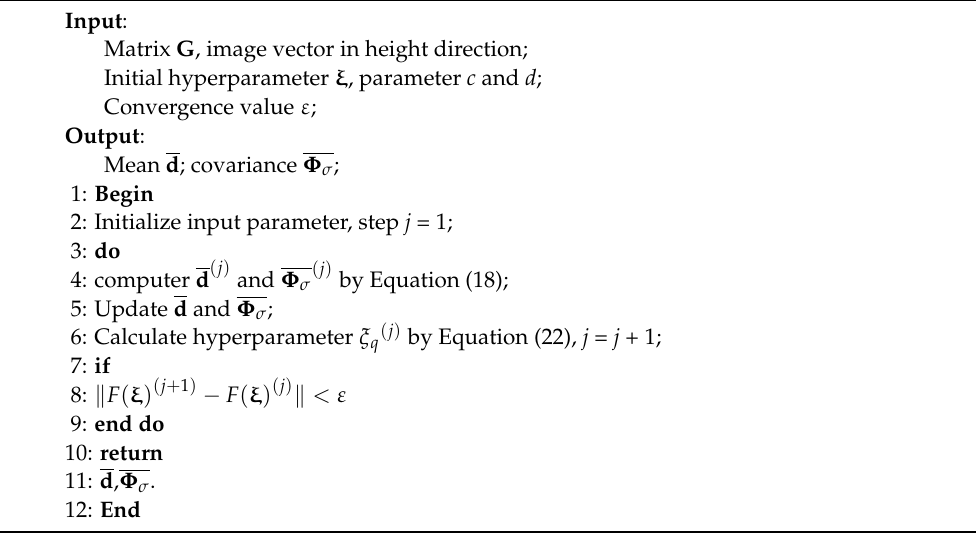
Algorithm 1: Procedure of SBL to Reconstruction Imaging along the height